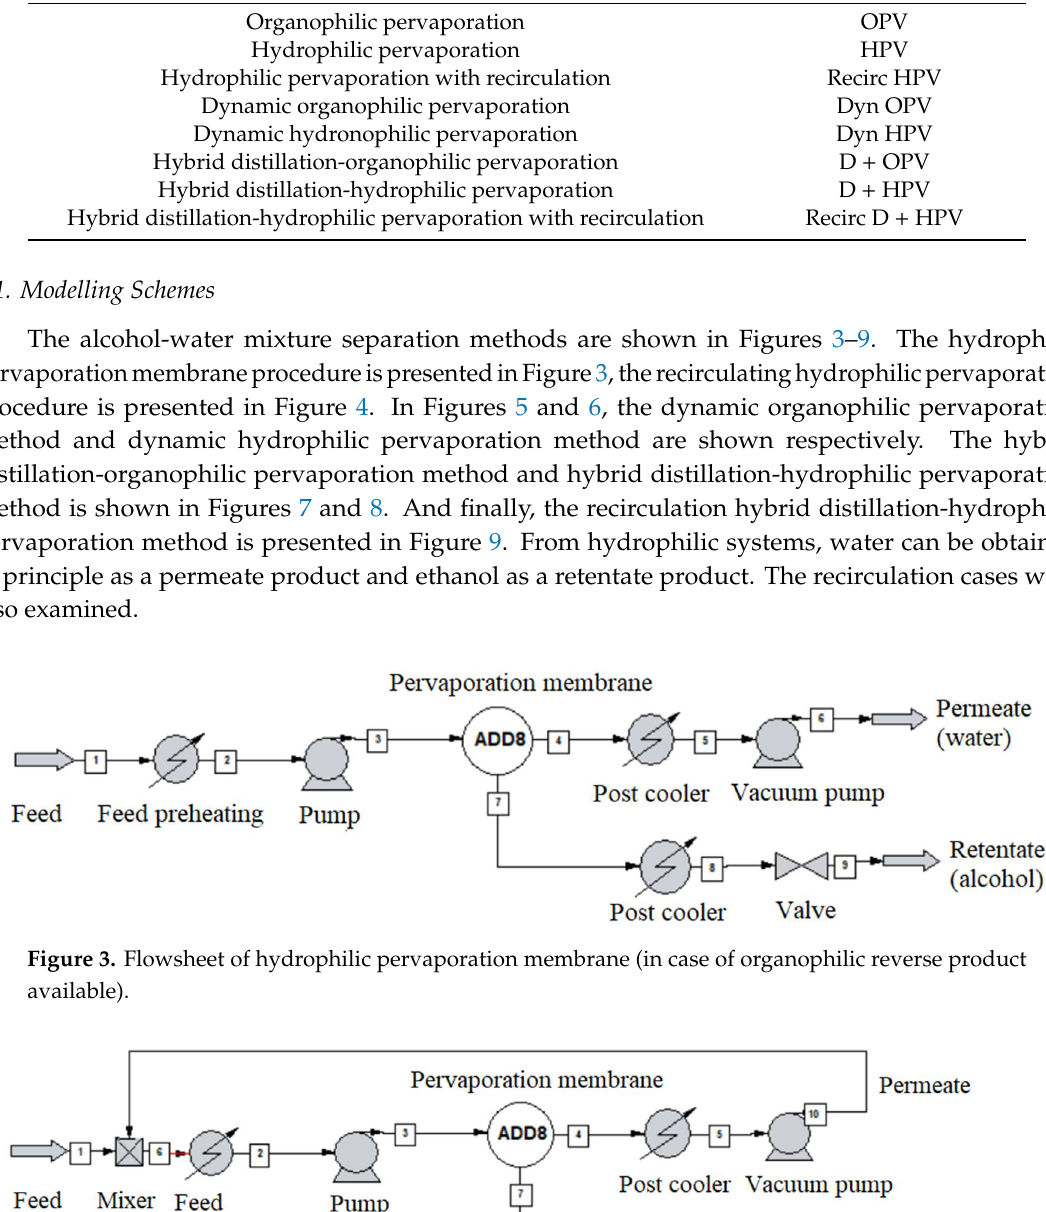
Figure 5. Flowsheet of dynamic organophilic pervaporation method. Figure 6. Flowsheet of dynamic hydrophilic pervaporation method.